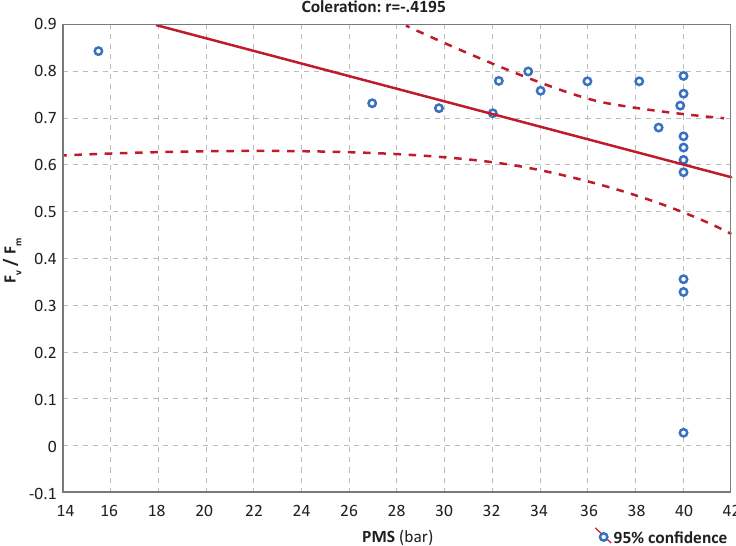
/F ) and water potential (bar) in normally v m